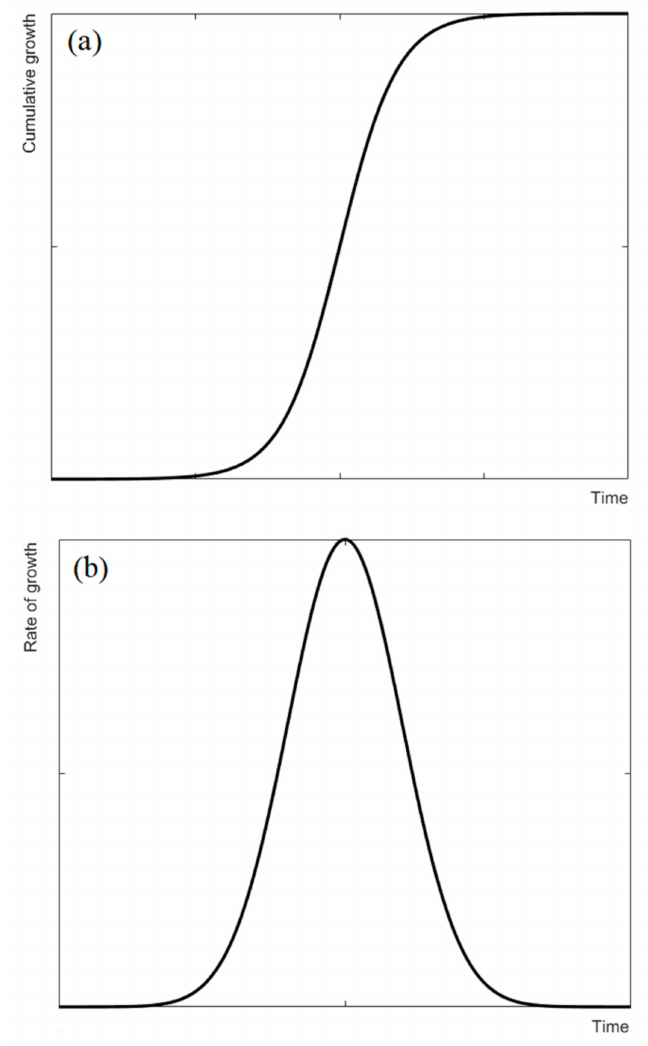
Figure 1. Typical ( a ) logistic function for the cumulative martensite volume fraction and ( b ) bell curves for the rate of change martensite volume